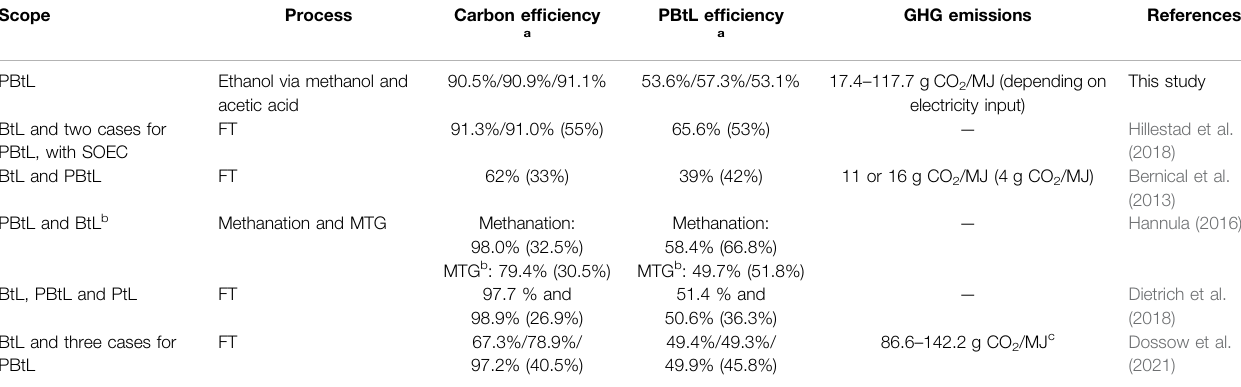
TABLE 7 | Reference studies of combined biomass/power to fuel